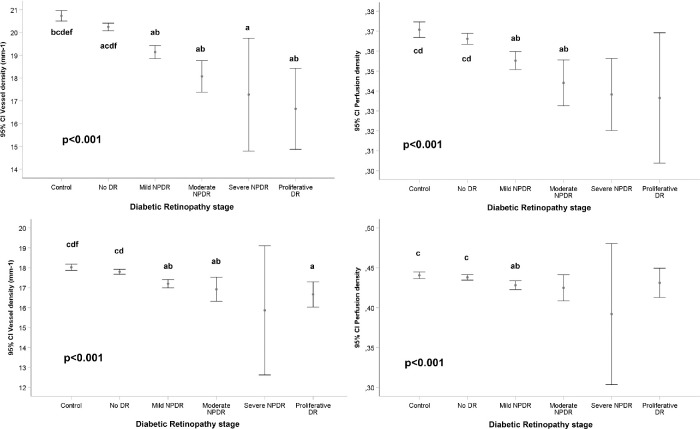
Vessel density (VD) and perfusion density (PD) measurements and diabetic retinopathy (DR) grade, after adjusting for age, gender, signal strength index (SSI), axial length and duration of diabetes mellitus disease. Top: VD (left) and PD (right) measurements in the complete scanned area using the 3 × 3 mm scanning protocol. Bottom: VD (left) and PD (right) measurements in the complete scanned area using the 6 × 6 mm scanning protocol. Generalized Estimating Equation (GEE) adjusted for age, gender, signal strength index (SSI), axial length, and duration of diabetes mellitus disease for global P value; pairwise comparisons by Kruskal-Wallis test with Bonferroni correction. P < 0.05: (a) vs. Control; (b) vs. No DR; (c) vs. Mild DR; (d) vs. Moderate DR; (e) vs. Severe DR; (f) vs Proliferative DR (Total number of eyes [3 × 3/6 × 6]: control 189/183, no DR 504/503, mild NPDR 202/198, moderate NPDR 29/30, severe NPDR 4/3, PDR 10/10).